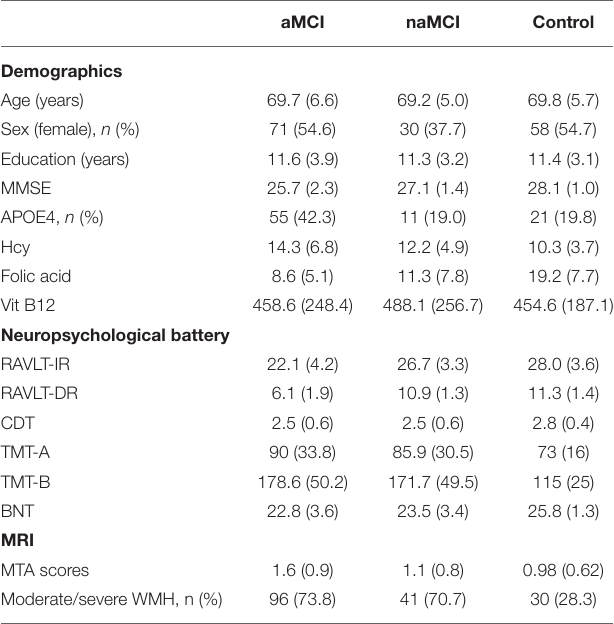
TABLE 1 | Demographic, neuropsychological, and MRI